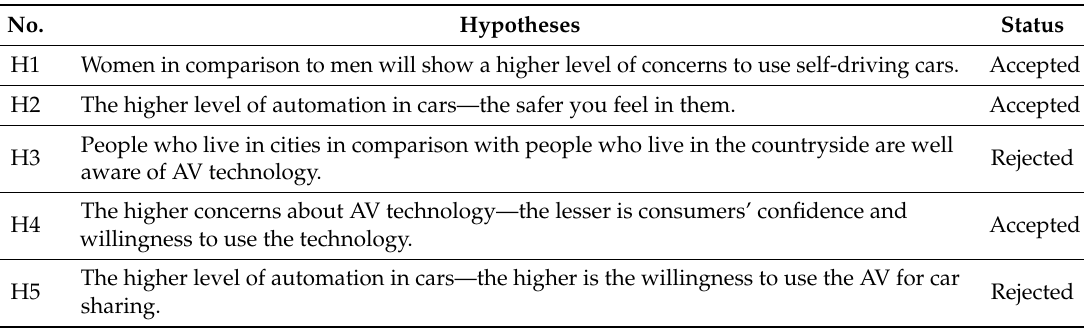
Table 21. Hypotheses assessment summary